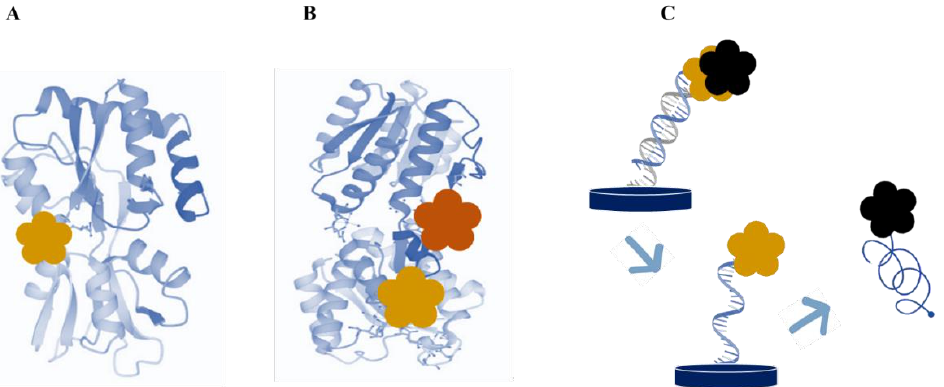
Figure 1. ( A ) First configuration: Fluorophore labeled to a strategic site of the biocomponent to sense changes in the microenvironment due to variations in its conformation. ( B ) Second configuration: Donor/acceptor pair of fluorophores labeled to selected sites of the biocomponent (Förster resonance energy transfer, FRET). ( C ) Third configuration: Fluorophore–quencher pair to provide electron transfer-based fluorescence quenching.